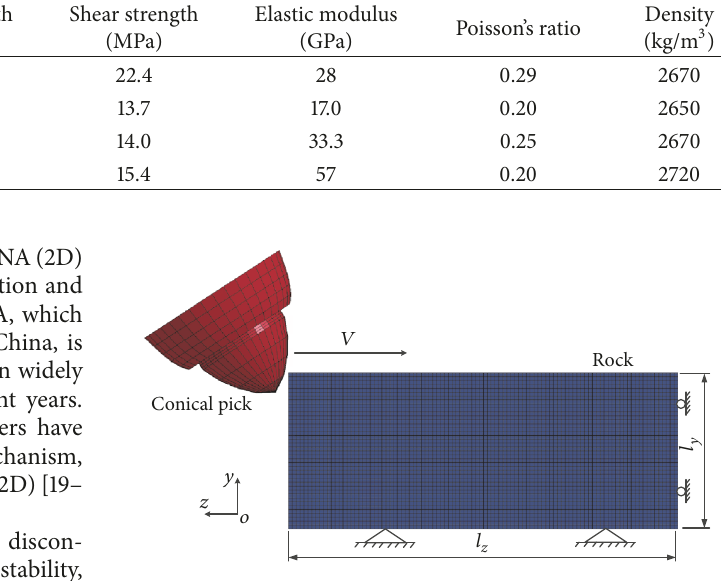
Figure 3: The rock cutting